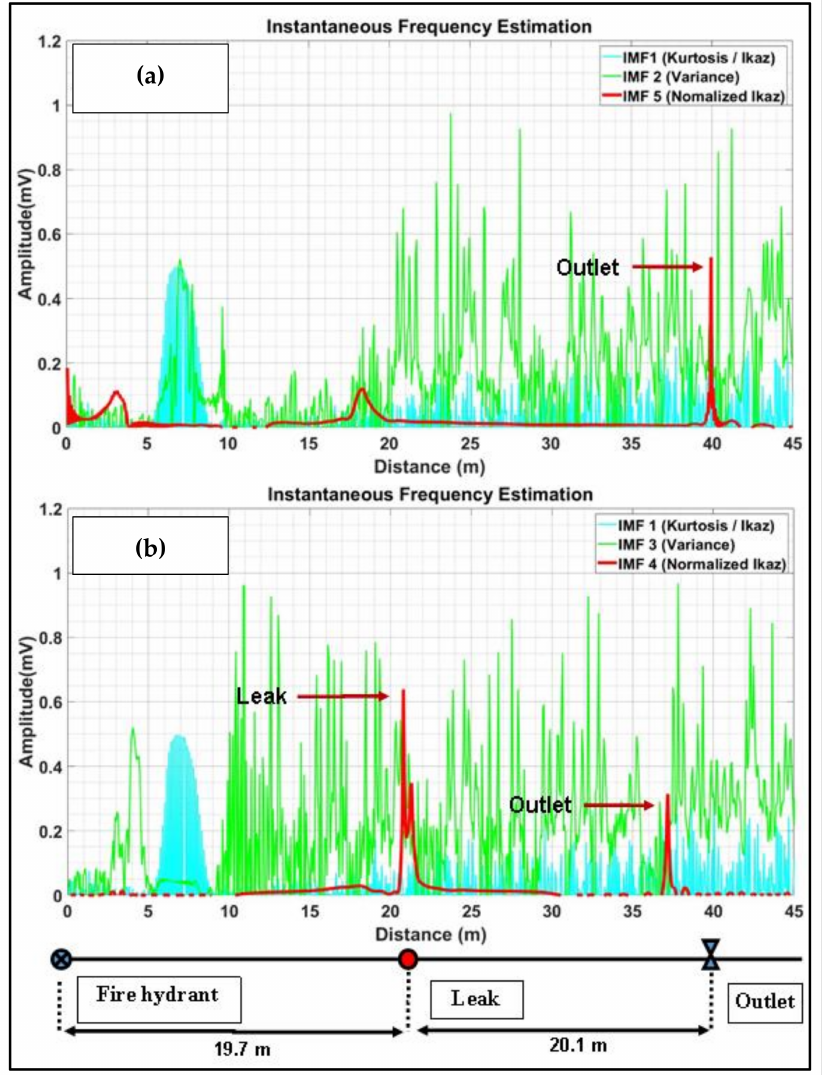
Figure 14. Hilbert Transform (HT) analysis with 4 bar for pipeline system pressure: ( a ) IMF series 5 (no-leak) ( b ) IMF series 5 (1 mm circular